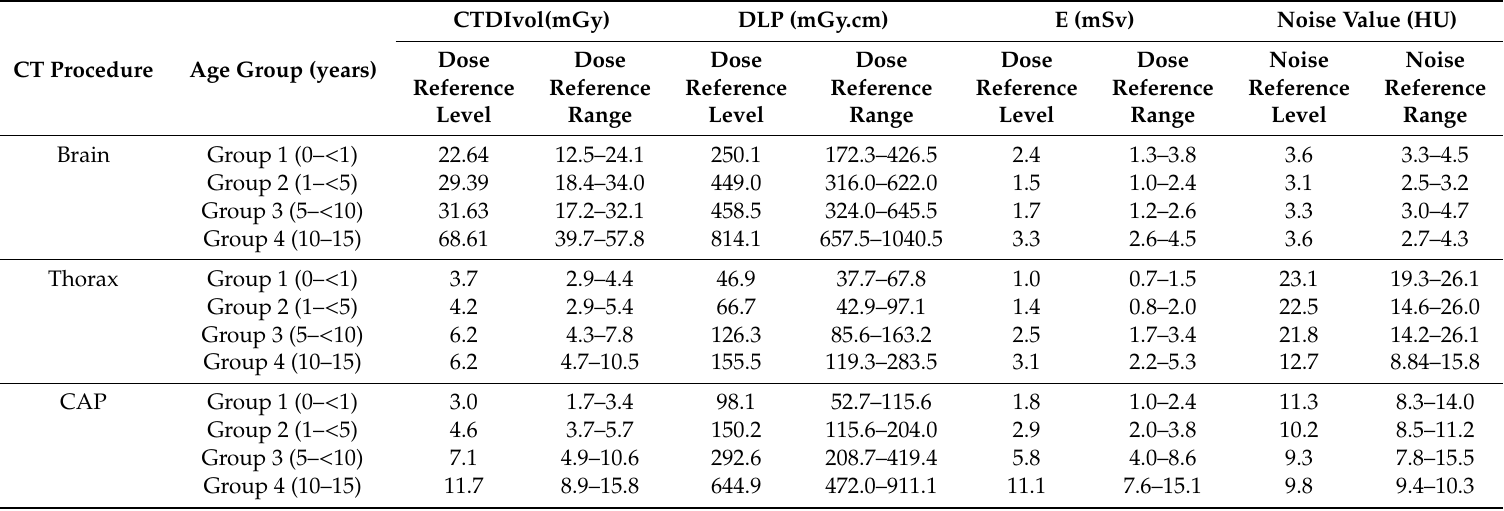
Table 4. Dose reference levels and ranges of CTDI vol , DLP, and E and noise reference levels and ranges in CT brain, CT thorax and CT